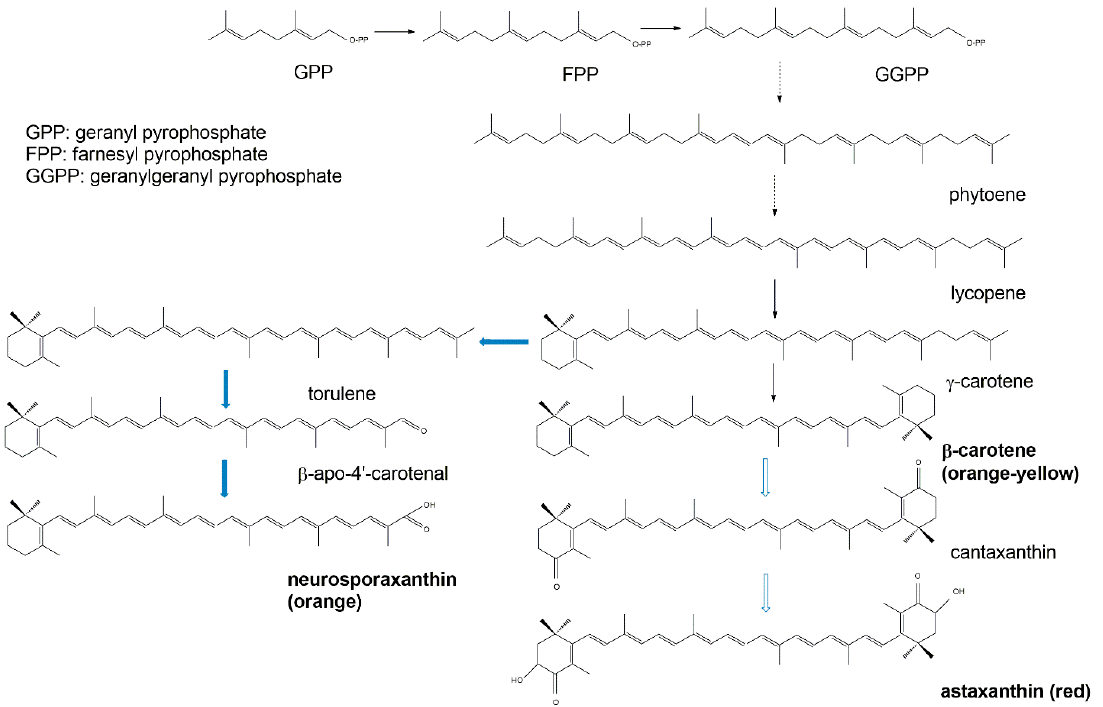
Figure 8. Simplified scheme of the biosynthetic pathways for β-carotene (black arrows) and the astaxanthin and neurosporaxanthin (blue arrows) from GPP.